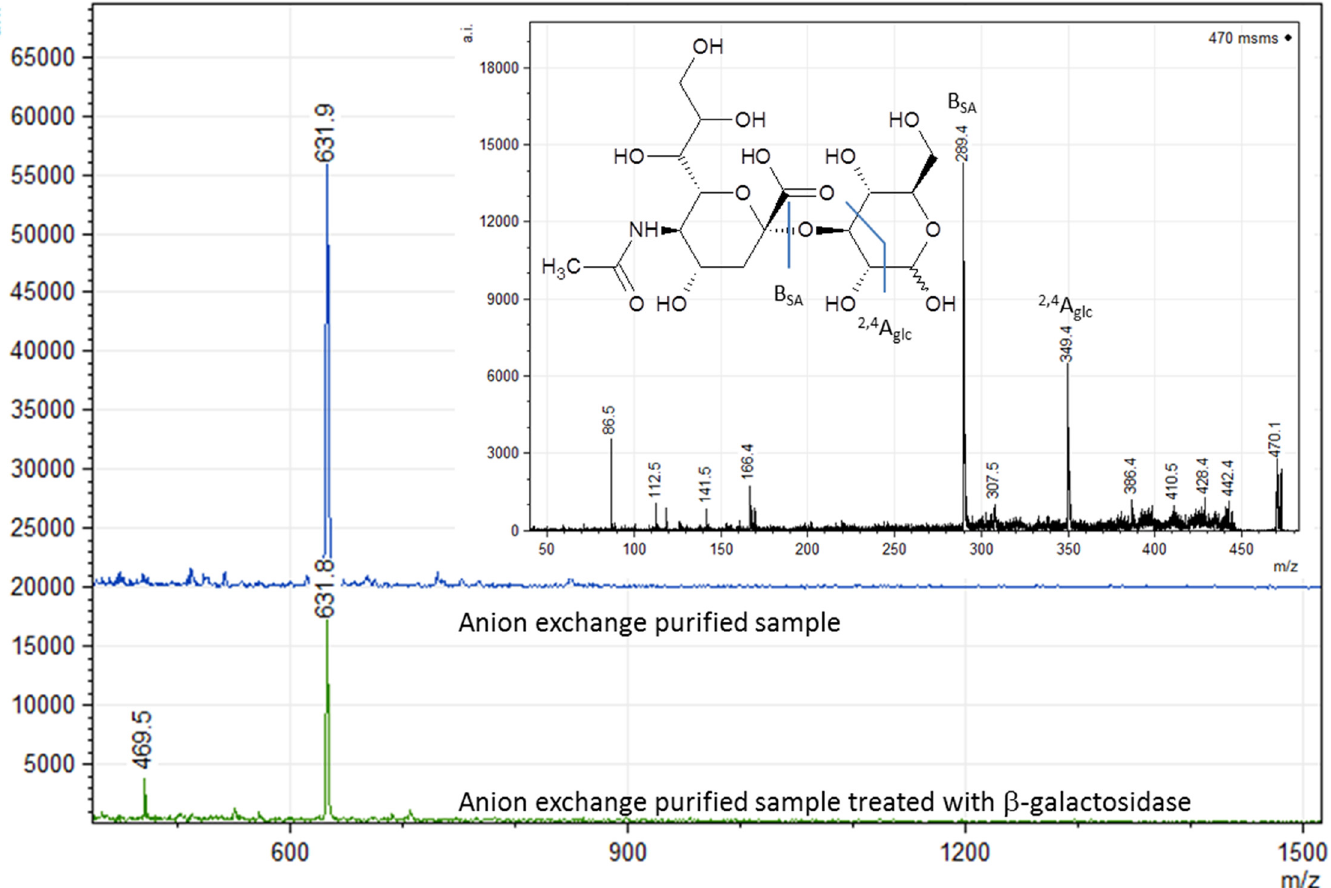
Fig 5. Identification of the novel trans-sialylation product by MALDI-TOF. MALDI-TOF of anion exchange purified SialH reaction mixture, i.e. all sialylated compounds in the reaction mixture, before and after β -galactosidase treatment. MALDI-TOF/TOF of m/z 632 in the untreated sample is consistent with the presence of a SL type compound. MALDI-TOF/TOF of m/z 470 ion in the β -galactosidase treated sample is the result of sialyllactose breakdown, which suggests a non-sialylated galactose moiety and thus, a sialylated glucose moiety. MS-MS of the m/z 470 ion is consistent with breakdown of sialylated glucose. Two ions resulted in significant peaks (B SA = sialic acid-ion and A glc = glucose-ion) and are, together with the suggested bond cleavage, indicated in the figure.